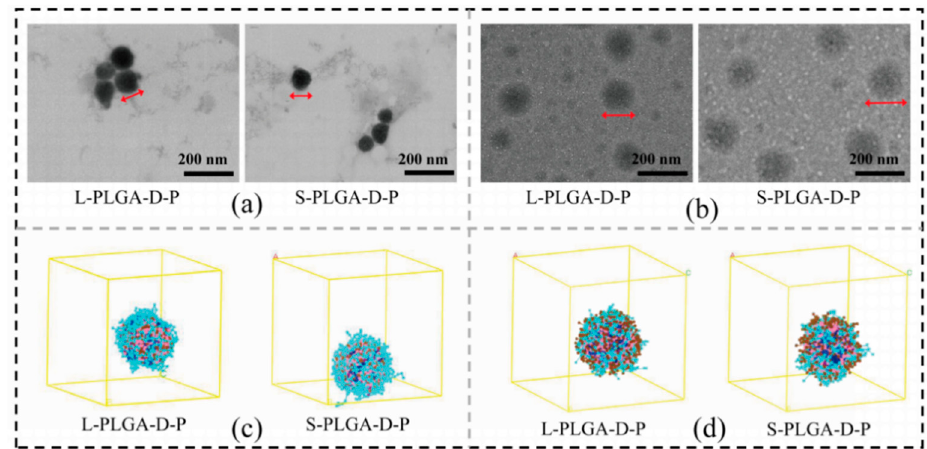
Figure 5. TEM images of self-assembled polymeric micelles at pH 7.4 ( a ) and pH 5.0 ( b ). DPD equilibrium states of polymeric micelles at neutral ( c ) and acidic condition ( d ). The beads of Ad, LA, GA, MAA, DEA (DEAH), TriAZO and mPEG were represented in red, blue, indigo, pink, brown, purple and light blue,